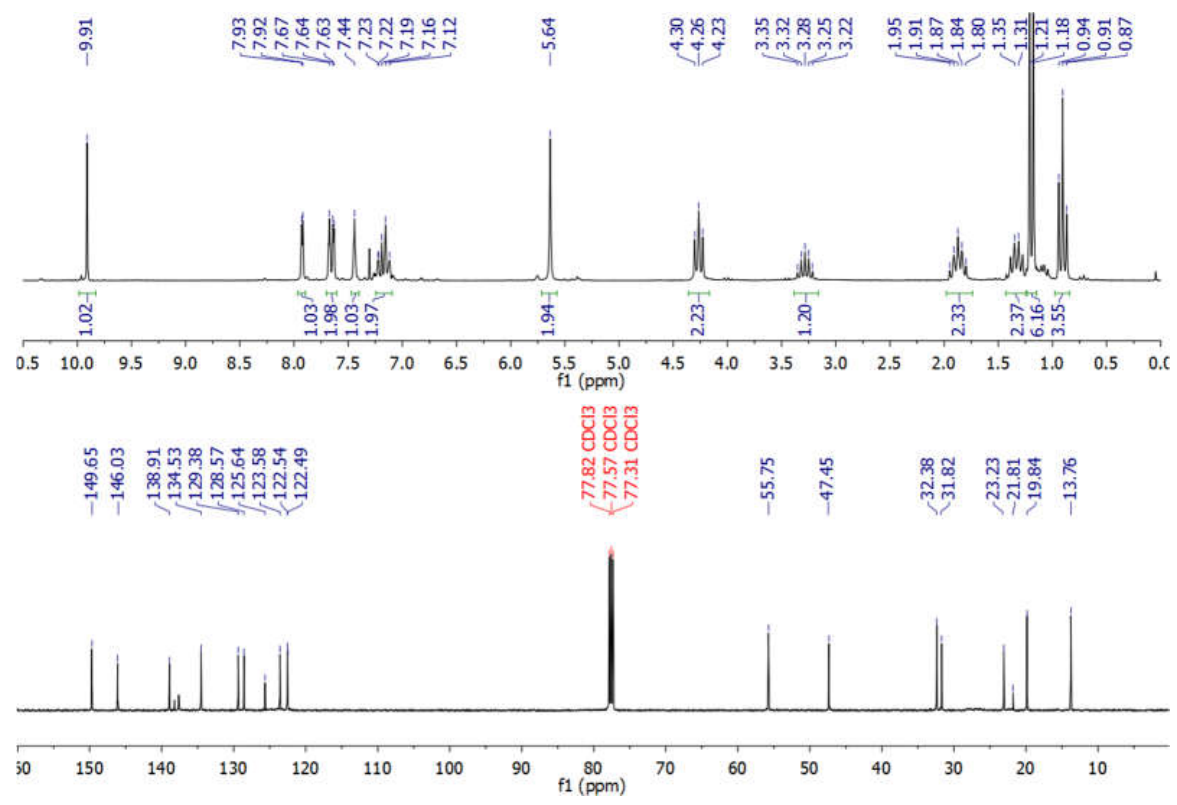
Figure 3. 1 HNMR (200 MHz) and 13 CNMR (125 MHz) of BAIIL ( 3e ) in CDCl 3 .